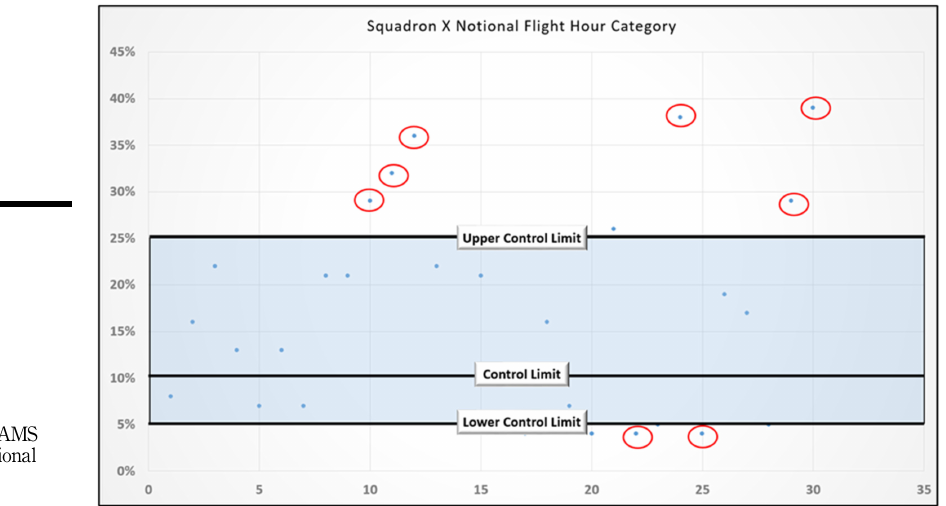
Figure 6. Envisioned AAMS Report on notional